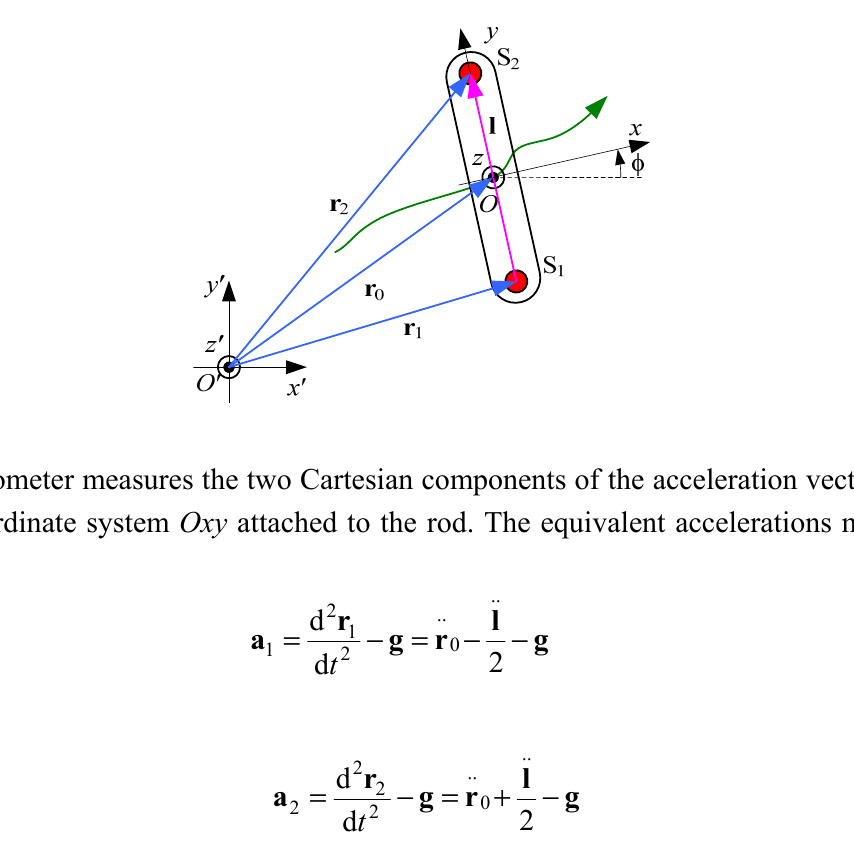
Figure 2. Rod with two accelerometers and the coordinate system for analysis of movement in the sagittal